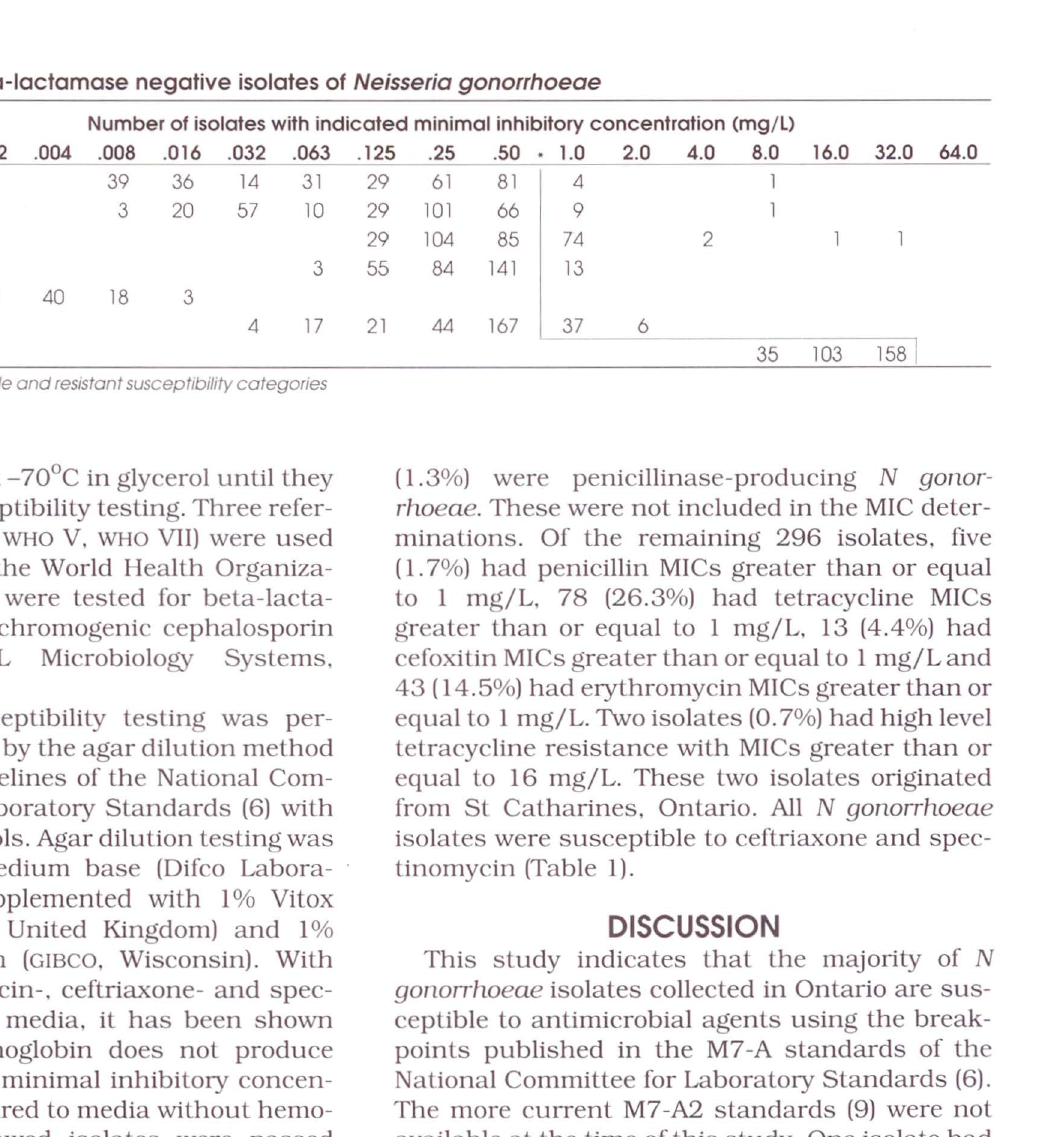
Susceptibility of 296 beta-lactamase negative isolates of Neisseria gonorrhoeae Antibiotic Number of isolates with indicated minimal inhibitory concentration (mg/ L)